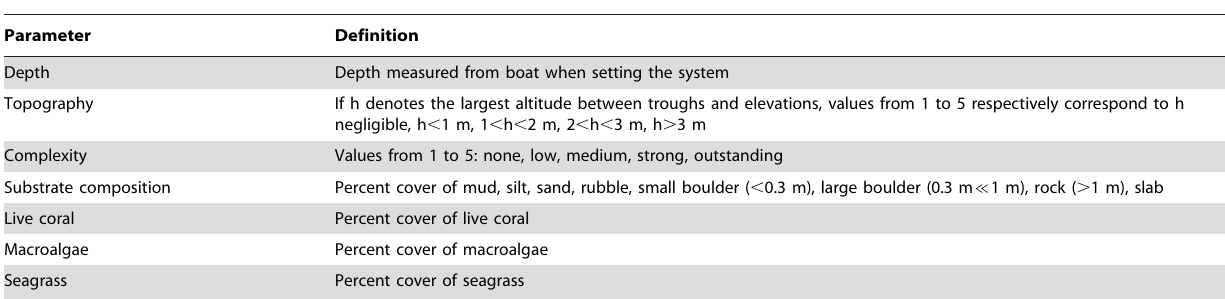
Table 2. Habitat